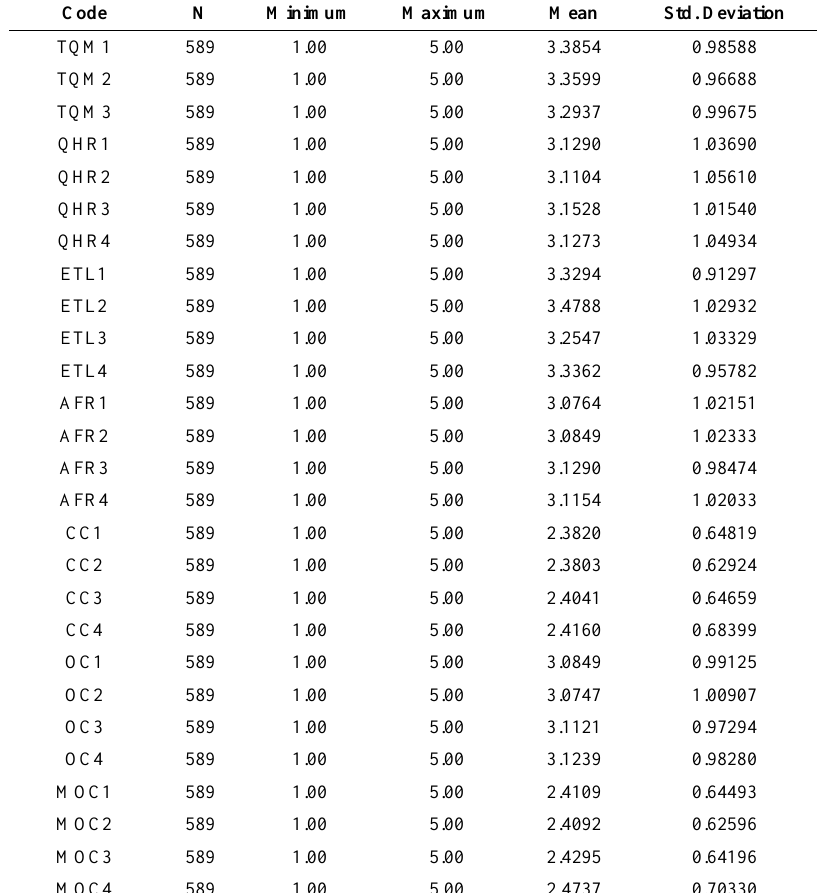
Table 1. Descriptive statistics for factors affecting the total quality management and competitive